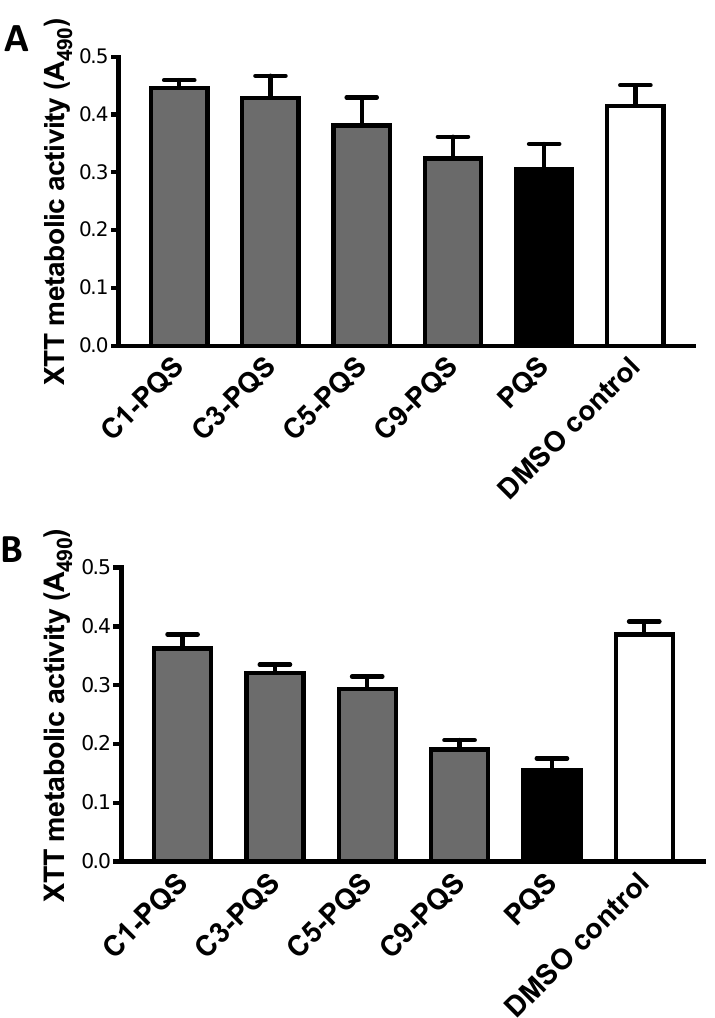
Figure 7. Studies of alkyl side chains on PQS. Effects in hypoxic environment. All molecules tested at 1.56 µ g/mL. DMSO control results same as ethanol control. ( A ) Target 10AF. C1-PQS appears to boost slightly, compared to controls. C9-PQS and PQS inhibit significantly (both p < 0.001) compared to controls. PQS more inhibitory compared to C1-PQS, C3-PQS, C5-PQS, C9-PQS, respectively p < 0.001, p < 0.001, p < 0.05, p > 0.05. ( B ) Target Af293. C3-PQS, C5-PQS, C9-PQS, PQS all inhibit ( p < 0.001) compared to controls, C1-PQS is p > 0.05 compared to controls. PQS more inhibitory compared to C1-PQS, C3-PQS, C5-PQS ( p < 0.001 for all), and C9-PQS ( p < 0.01).